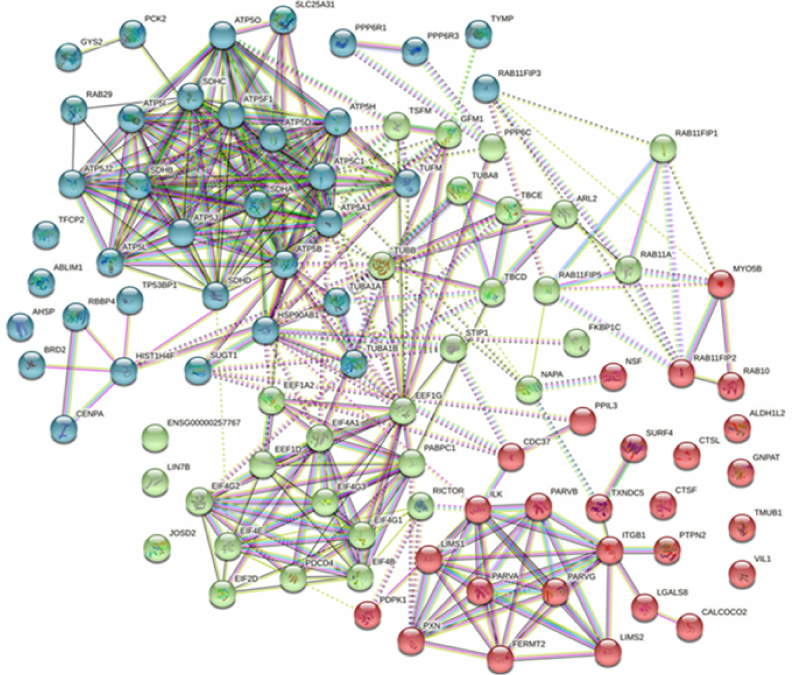
Figure 6. Protein–protein interaction (PPI) maps of prey proteins for bait ORF72. Network nodes represent proteins. Edges represent protein–protein associations, edges between clusters are dotted lines. Different colors represent three clusters that were distinguished by the K-means method, and the gene name information was listed in Supplementary Table